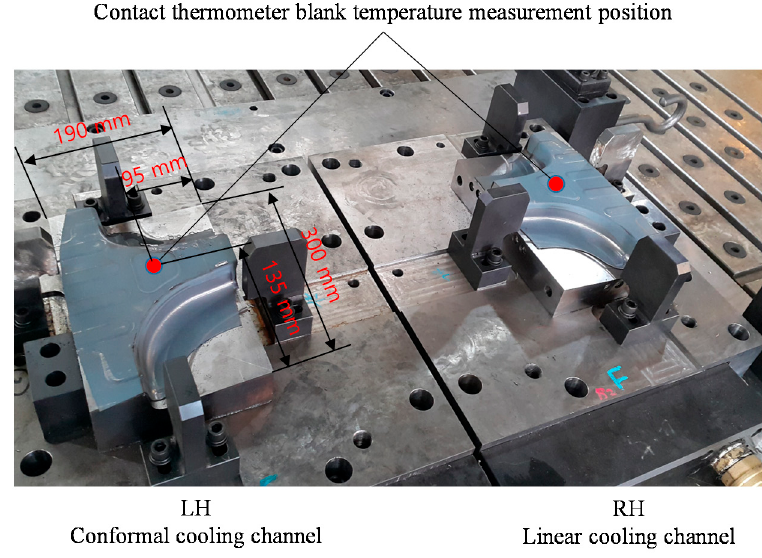
Figure 19. Product temperature measurement positions on the die-cooling block surface after forming and cooling. Table 12. Temperature results measured during stamping process.